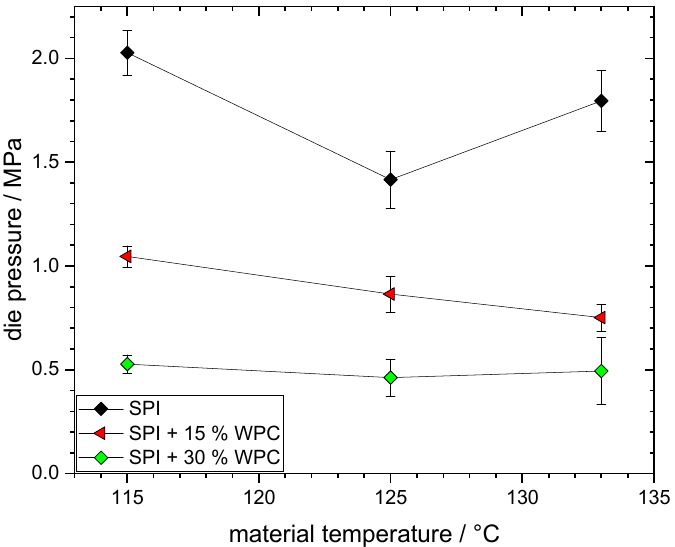
Figure 3. Die pressure as a function of material temperature for different protein blends (0–30% WPC).